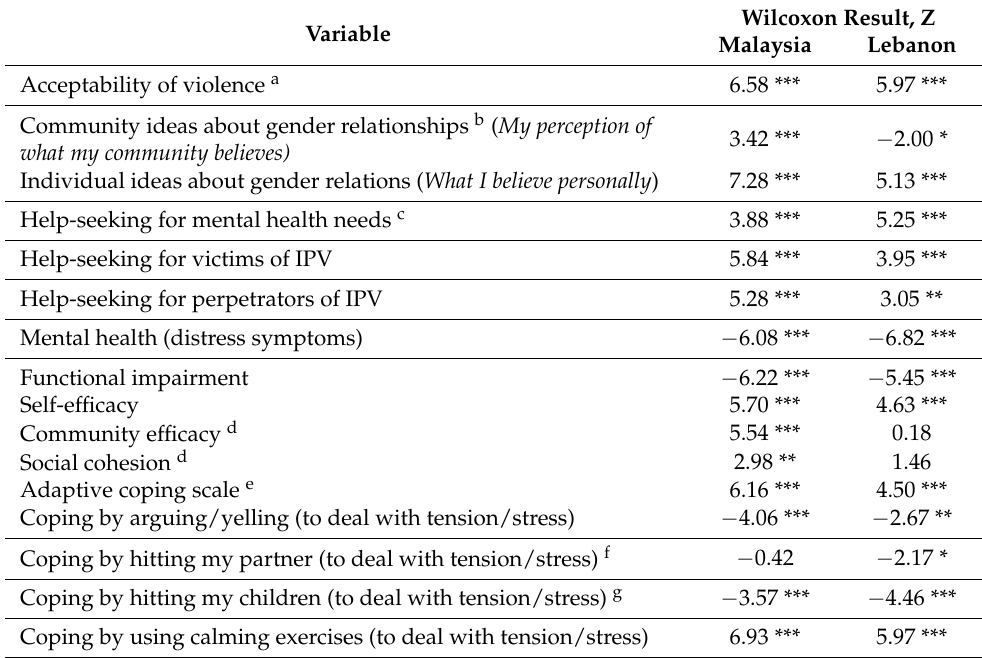
Table 3. Workshop outcomes (pre- to